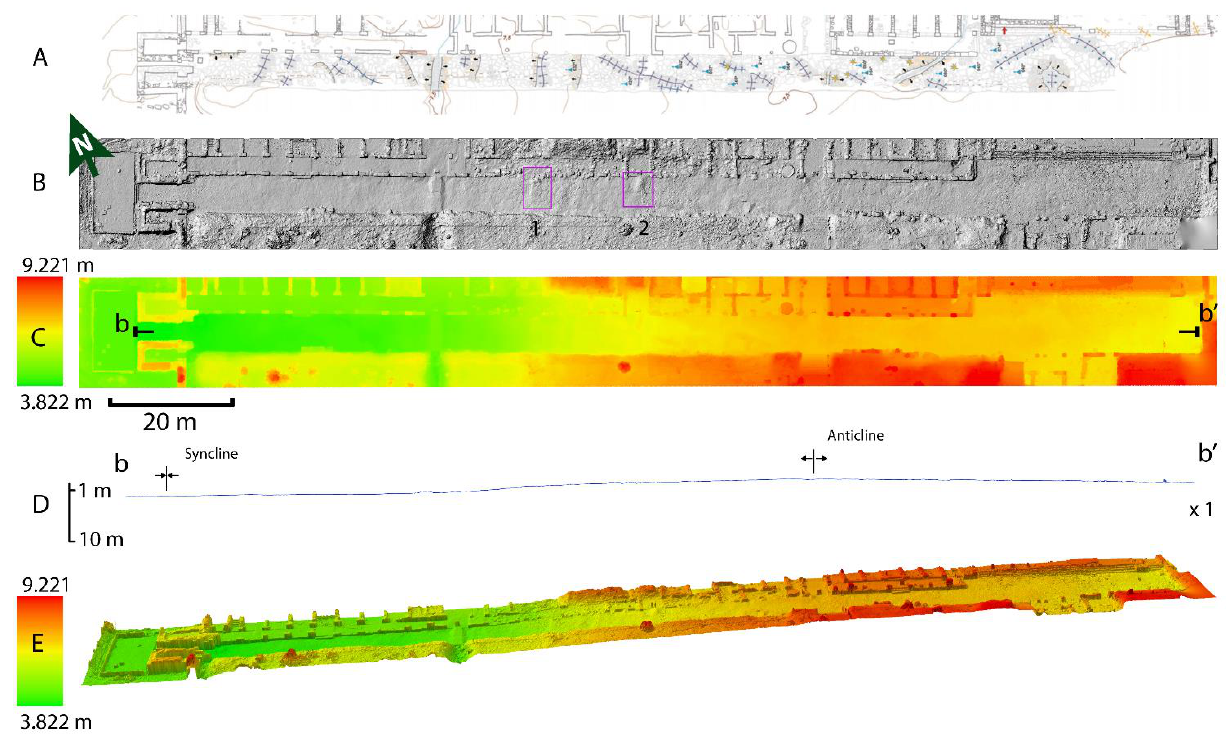
Figure 9. ( A ) Folds and deformational structures related to the CE VI s. earthquake in the Decumanus maximus mapped in a conventional topographic map, modified from Silva et al. [14]. ( B ) Hillshade model derived from a DEM obtained from drone aerial photogrammetry; area of the Decumanus maximus . Purple rectangles indicate folds E (1) and F (2) in Figure 9. ( C ) Hypsometry of the DEM of the Decumanus maximus obtained from drone aerial photogrammetry; note that the total differential elevation accounts for 5.339 m in more than 180 m. ( D ) Topographic profile from b to b’ (see location in C) without vertical exaggeration. A gentle folding in the paving of the Decumanus maximus can be seen. ( E ) A 3D view from the SW of the Decumanus maximus ; note the overall folding of the street.